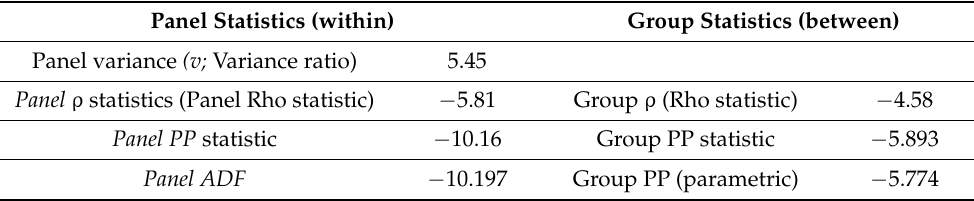
Table 6. Pedroni’s cointegration test results.